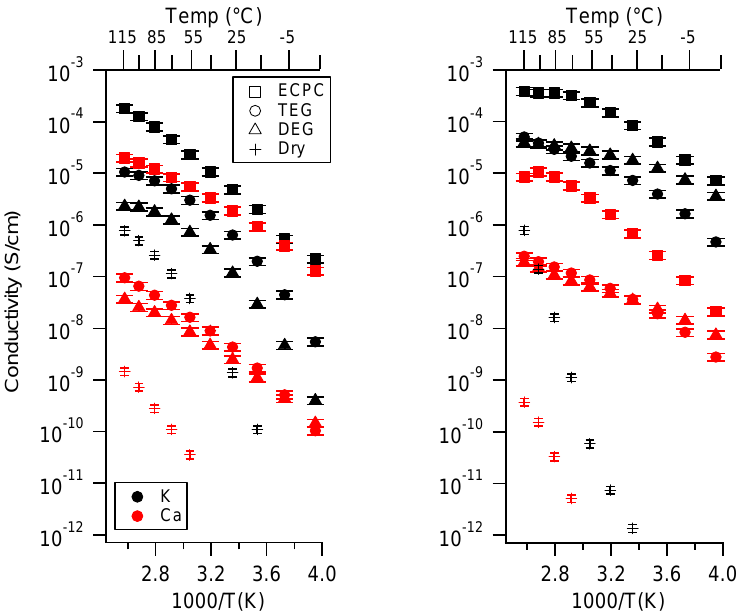
Figure 5. Conductivity as a function of swelling state for PEGDMA1000_low_SSM (left) and PTHFDA1000_low_STFSIM (right) SIPEs. Temperatures ranged from − 20 °C to 115 °C.